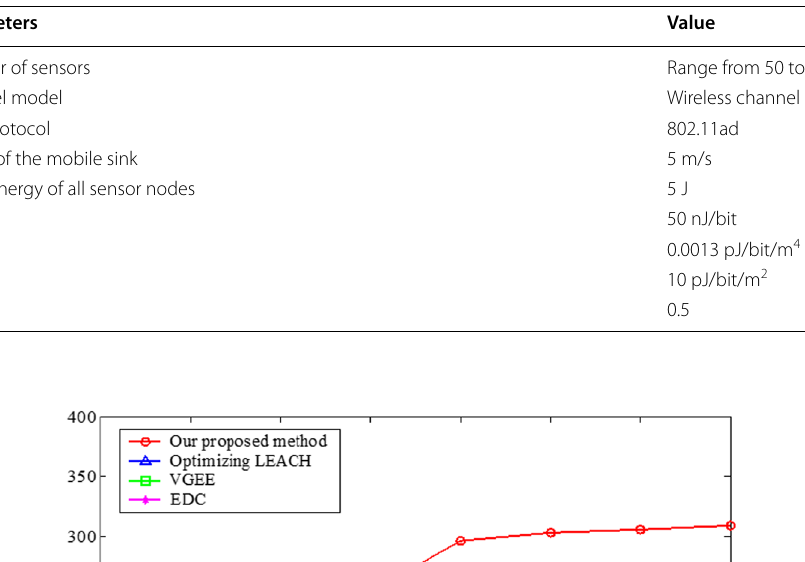
Table 2 Simulation